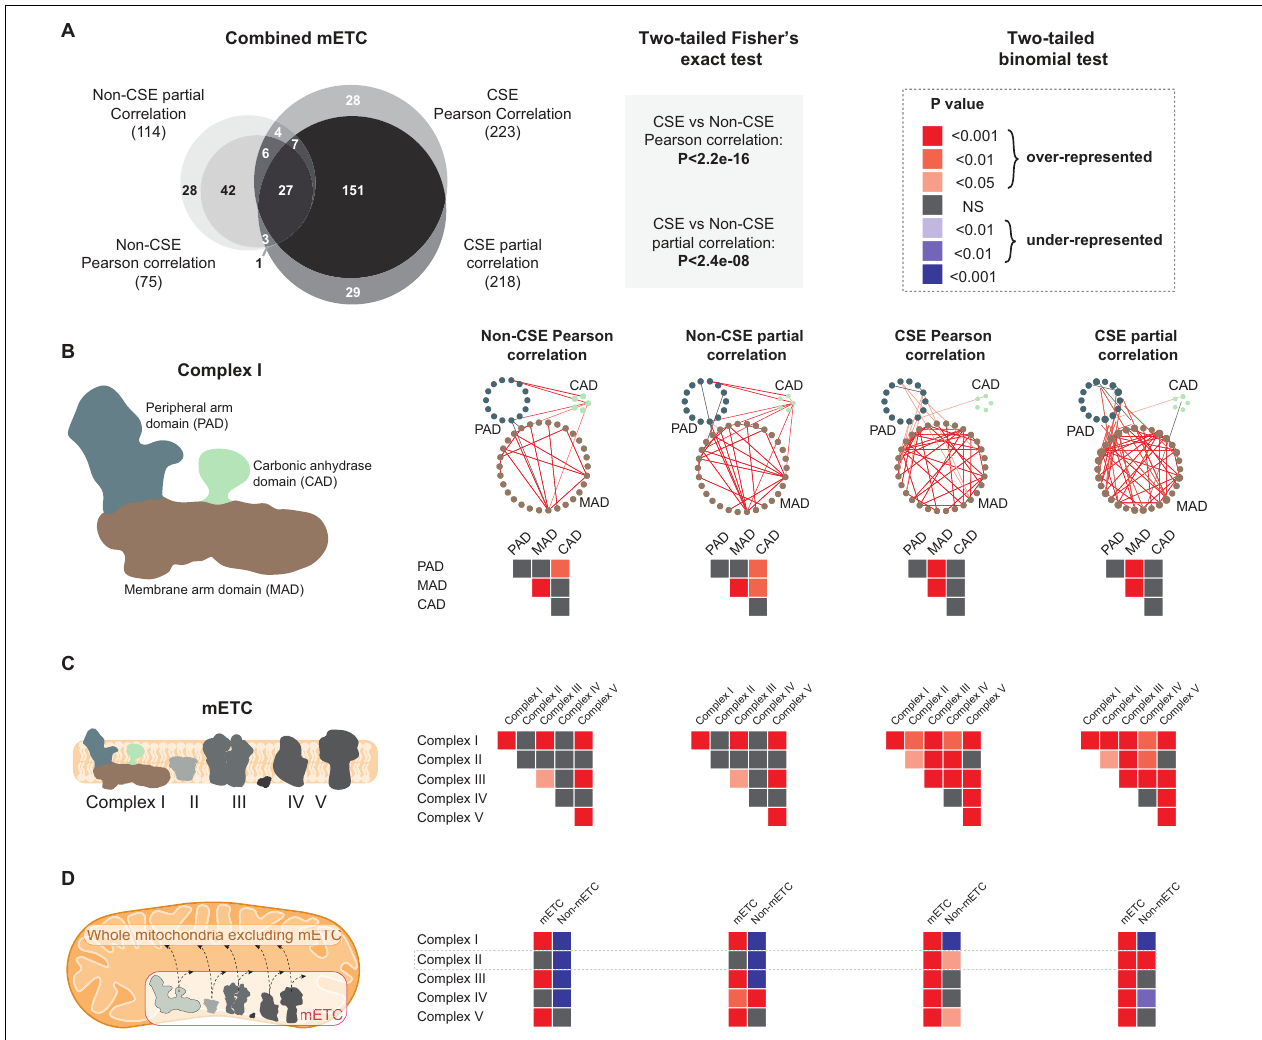
FIGURE 3 | Comparative analysis of four different correlation methods in defining interactions based on functional proximity. The following gene subsets of the mitochondrial electron transport chain were analyzed using non-CSE Pearson correlation, non-CSE partial correlation, CSE Pearson correlation and CSE partial correlation. P -values were calculated (two-tailed binomial test) for the probability associated with the expected vs. observed number of edges and a color-grading scheme of the resulting P -values applied. (A) A Venn diagram illustrating the overlap of connections between the complexes of the mitochondrial electron transport chain (mETC), when analyzed using the four different correlation methods. A two-tailed Fisher’s exact test was employed to test the significance of the difference in the number of edges (derived from connections within and between the five complexes of the mETC) in the networks based on non-CSE vs. CSE data. (B) The significance of the edges between the three domains of Complex I. (C) The significance of the edges within a given complex or between the different complexes of the ETC. (D) Between the individual complexes of the mETC vs. the unified mETC or the rest of the mitochondrial set excluding the mETC.